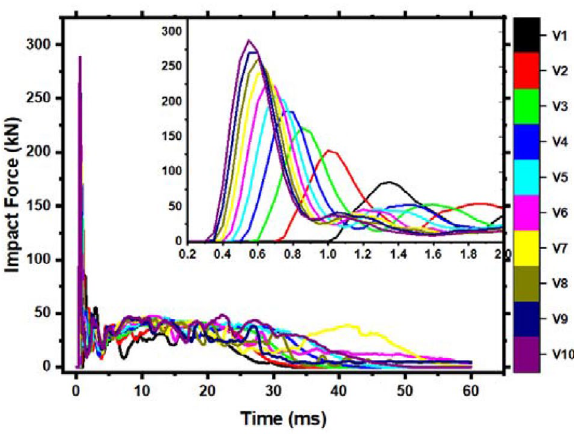
Figure 16. Impact force–time history curve of different impact velocity